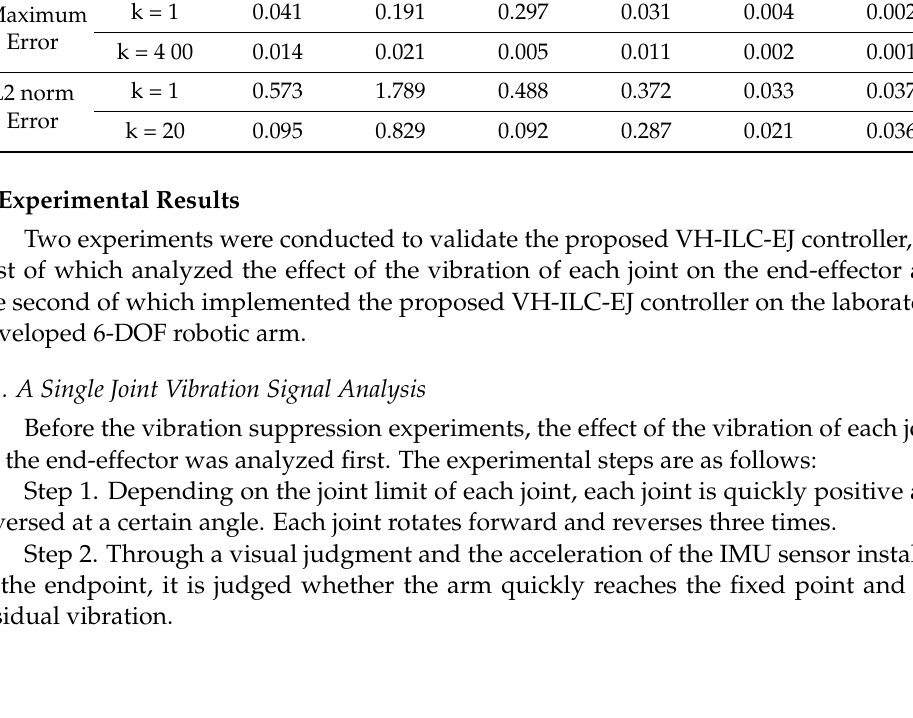
Table 3. Maximum tracking error and L2 norm of the error of an input-based ILC in simulation. Joint (rad) 1 2 3